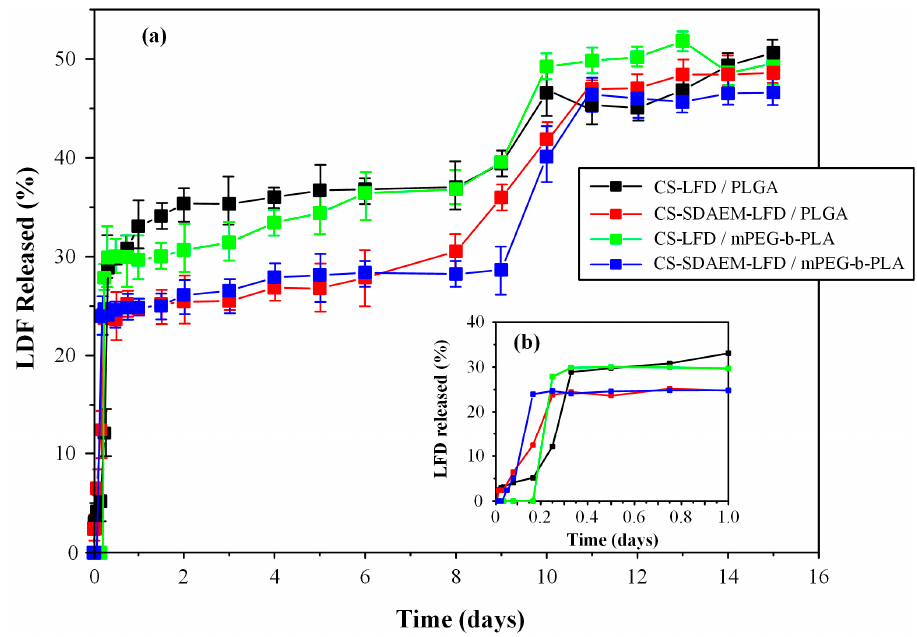
Figure 12. Full in vitro dissolution profile ( a ) and initial burst release ( b ) of mPEG-b-PLA and PLGA thin-films with LFD-loaded NPs.